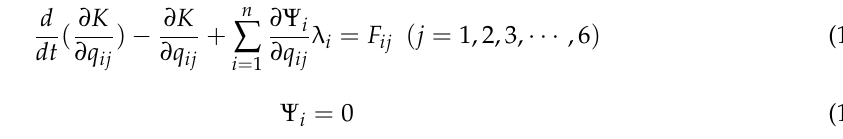
Figure 4. Data exchange. The piston’s model is built and packed as a supercomponent. The pistons, load and drive are assembled to be a hydraulic system model of the pump, and data exchange is built to transfer data between two models. 3.3. Co ‐ Simulation The simulation of the hydraulic ‐ mechanical coupling is conducted. The simulation parameters are shown in Table 1. The results are shown in Figure 5. Table 1. Simulation parameters. Parameter